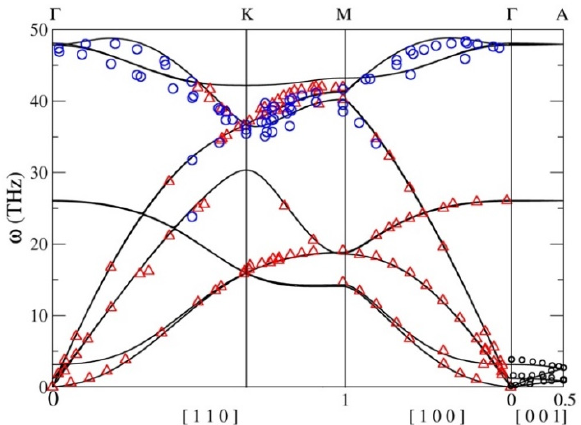
Figure 2. DFT (VASP) phonon dispersions for graphite (solid line). Data shown as blue circles, red squares, and black circles represent results from room-temperature experiments [23,26,27].